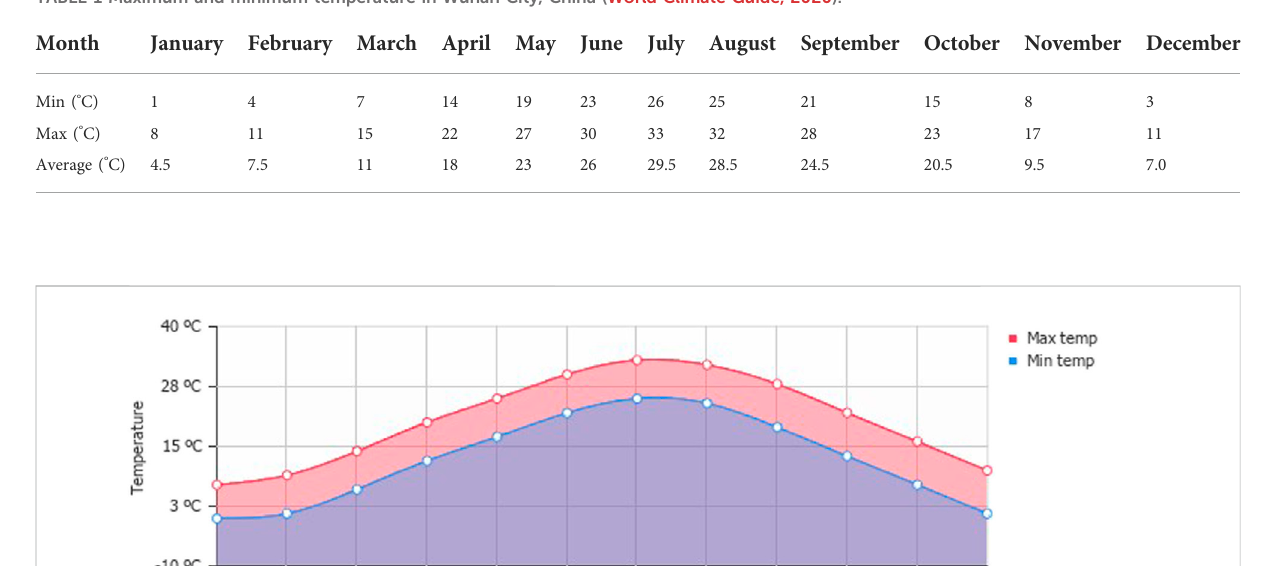
TABLE 1 Maximum and minimum temperature in Wuhan City, China (World Climate Guide, 2020).